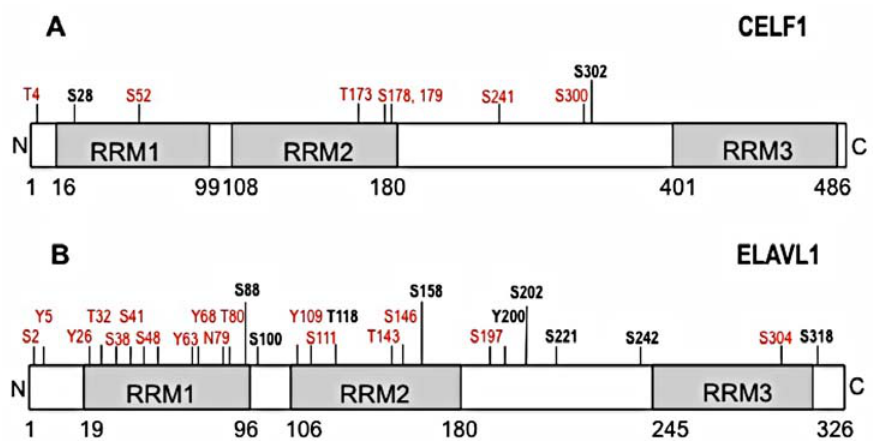
Figure 1. Schematic representation of predicted and verified phosphorylation sites on CELF1 and ELAVL1. Confirmed phosphorylation sites are depicted in bold black and predicted phosphorylation sites are depicted in red. The figure was built based on available information in PhosphoSitePlus software, Cell Signaling Technology, Inc. and publications cited in the text. ( A ) Phosphorylation sites for CELF1 (S28, S302) are implicated in changes in RNA binding affinity and altered mRNA splicing, translation and decay. ( B ) Phosphorylated residues for ELAVL1 are implicated in changes in intracellular localization (T118, S158, Y200, S202, S221, S242, S318), and mRNA translation (S158, S221).